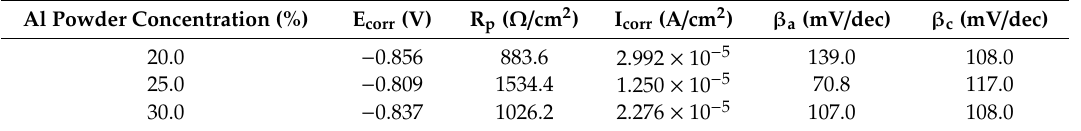
Figure 6. SEM of coating with Al powder: ( A ) 20.0%, ( B ) 25.0% and ( C ) 30.0%.